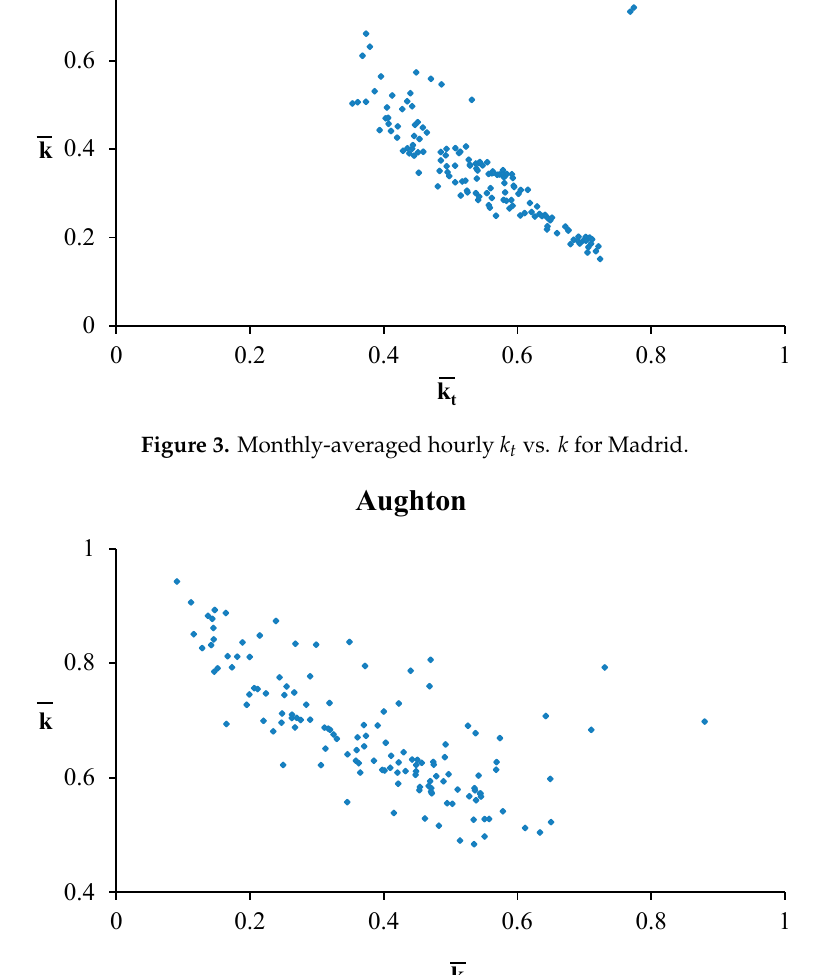
Figure 4. Monthly-averaged hourly k t vs. k for